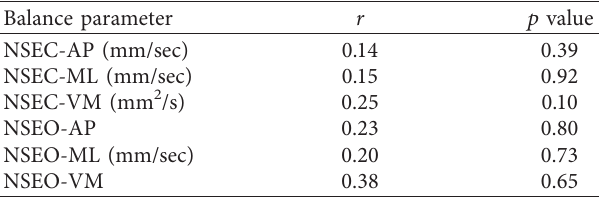
Table 4: Spearman’s rank correlation coefficient between Fev1% and balance parameter for COPD